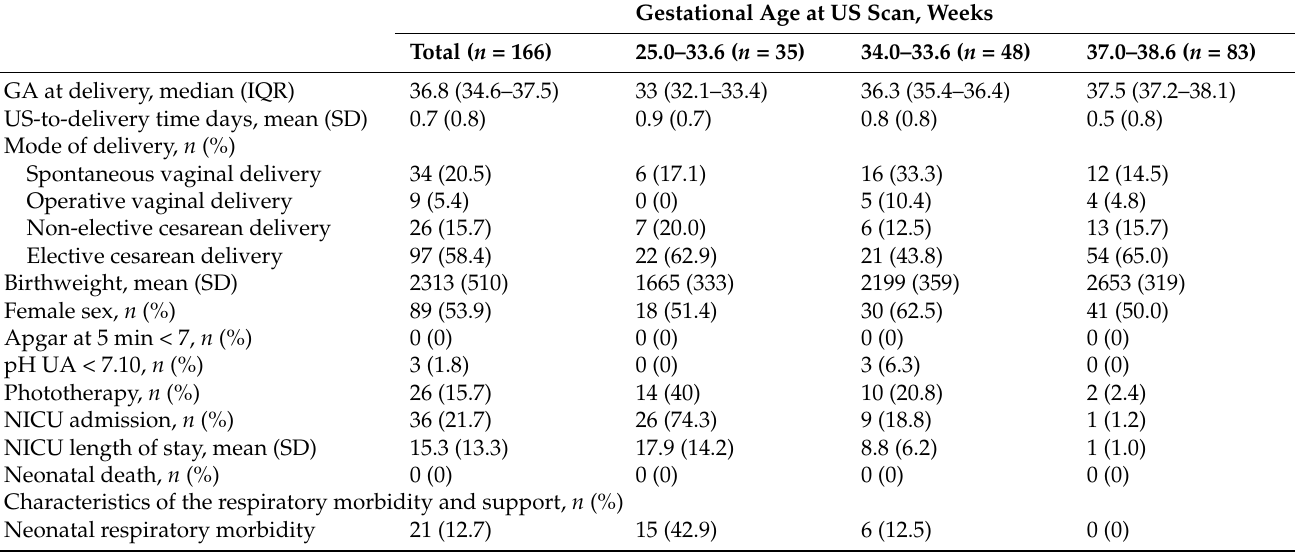
Table 2. Perinatal and neonatal